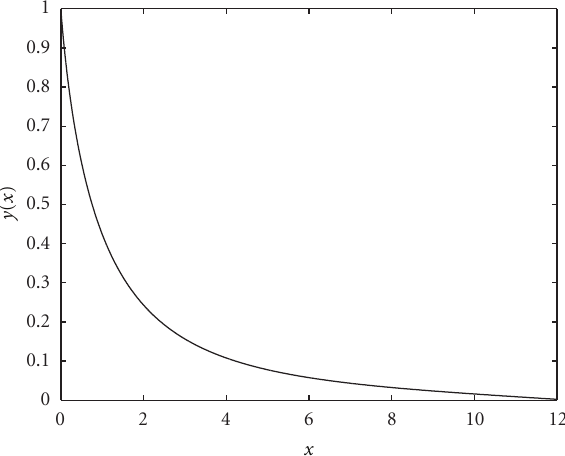
F 5: A plot of the numerical solution of the omas-Fermi problem (56)-(57), using